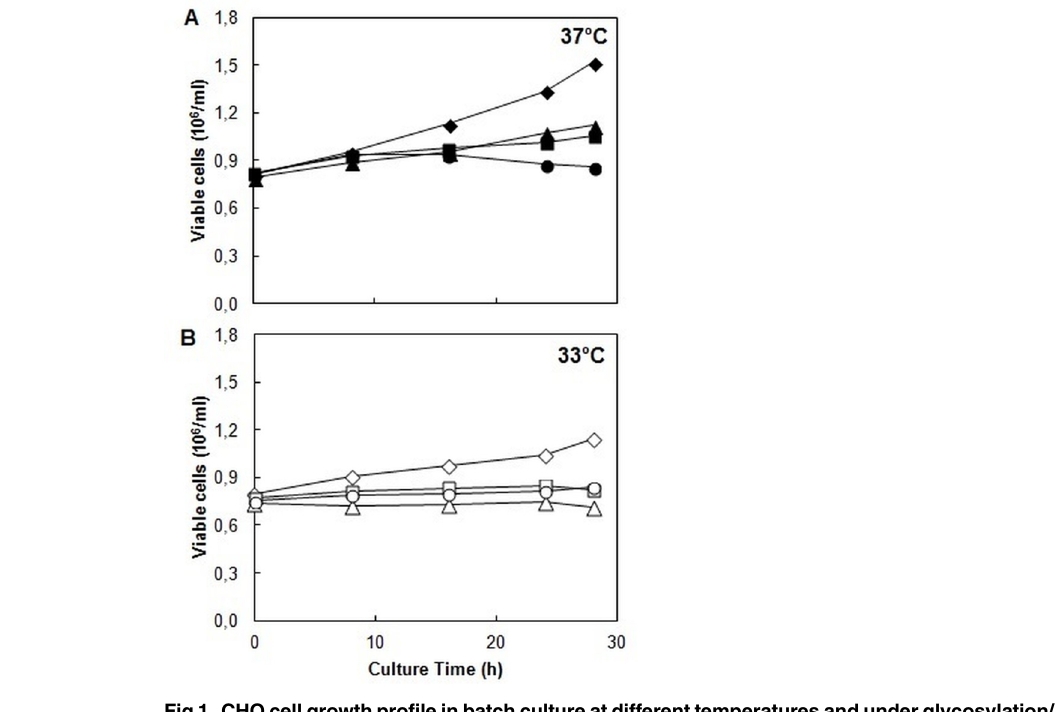
Fig 1. CHO cell growth profile in batch culture at different temperatures and under glycosylation/ ERAD inhibition. A: Viable cell concentration at 37°C. B: Viable cell concentration at 33°C. ◆ Control culture; ■ Tunicamicyn culture; ▲ Tunicamicyn/ERAD-I culture; ● Tunicamicyn/ERAD-II culture. (cid:5) Control culture; □ Tunicamicyn culture; 4 Tunicamicyn/ERAD-I culture; (cid:6) Tunicamicyn/ERAD-II culture.